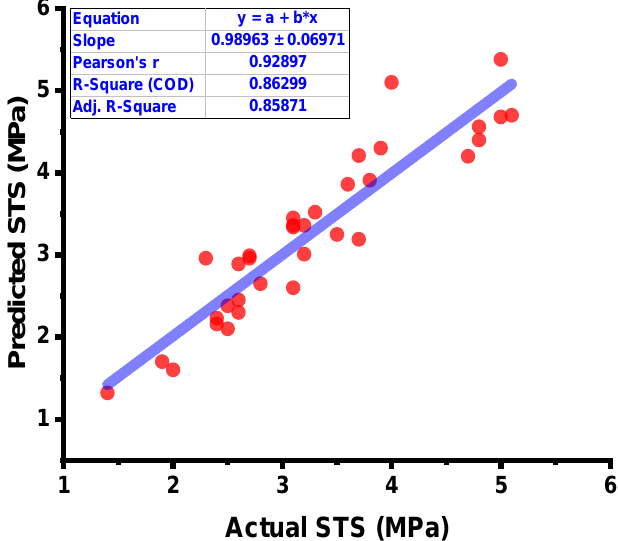
Figure 7. ANN model results comparison between the results from laboratory work and predictions.